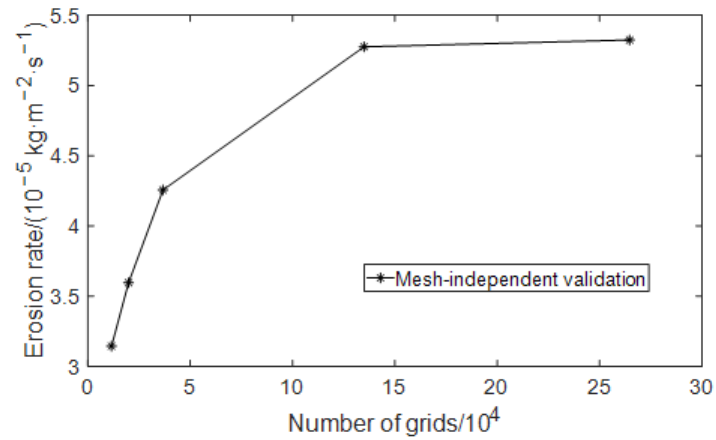
Figure 2. Mesh-independent validation of erosion rate model.